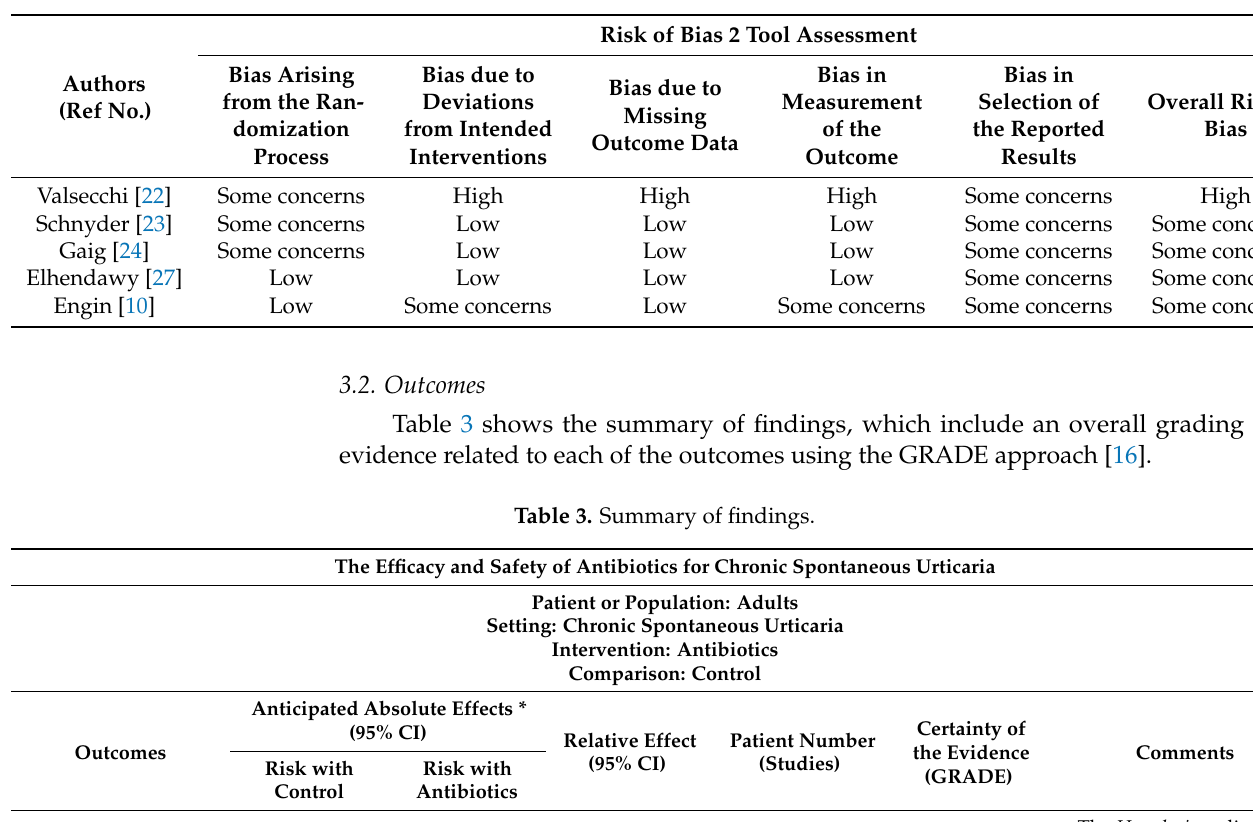
Table 2. Quality scores for the eligible studies for remission rate.